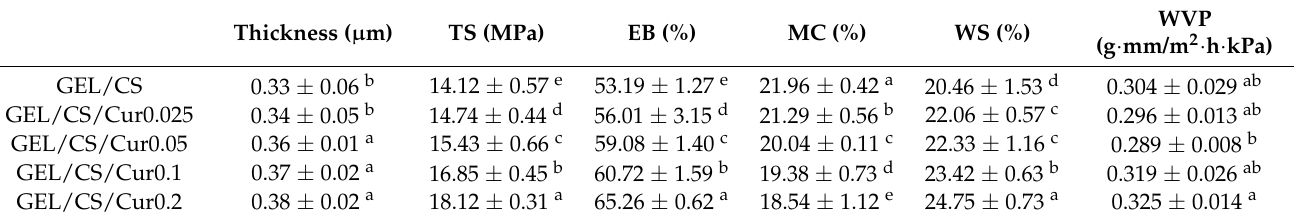
Table 3. Thickness, tensile strength (TS), elongation at break (EB), moisture content (MC), water solubility (WS), and water vapor permeability (WVP) of the GEL/CS films and those GEL/CS/Cur films with different concentrations of